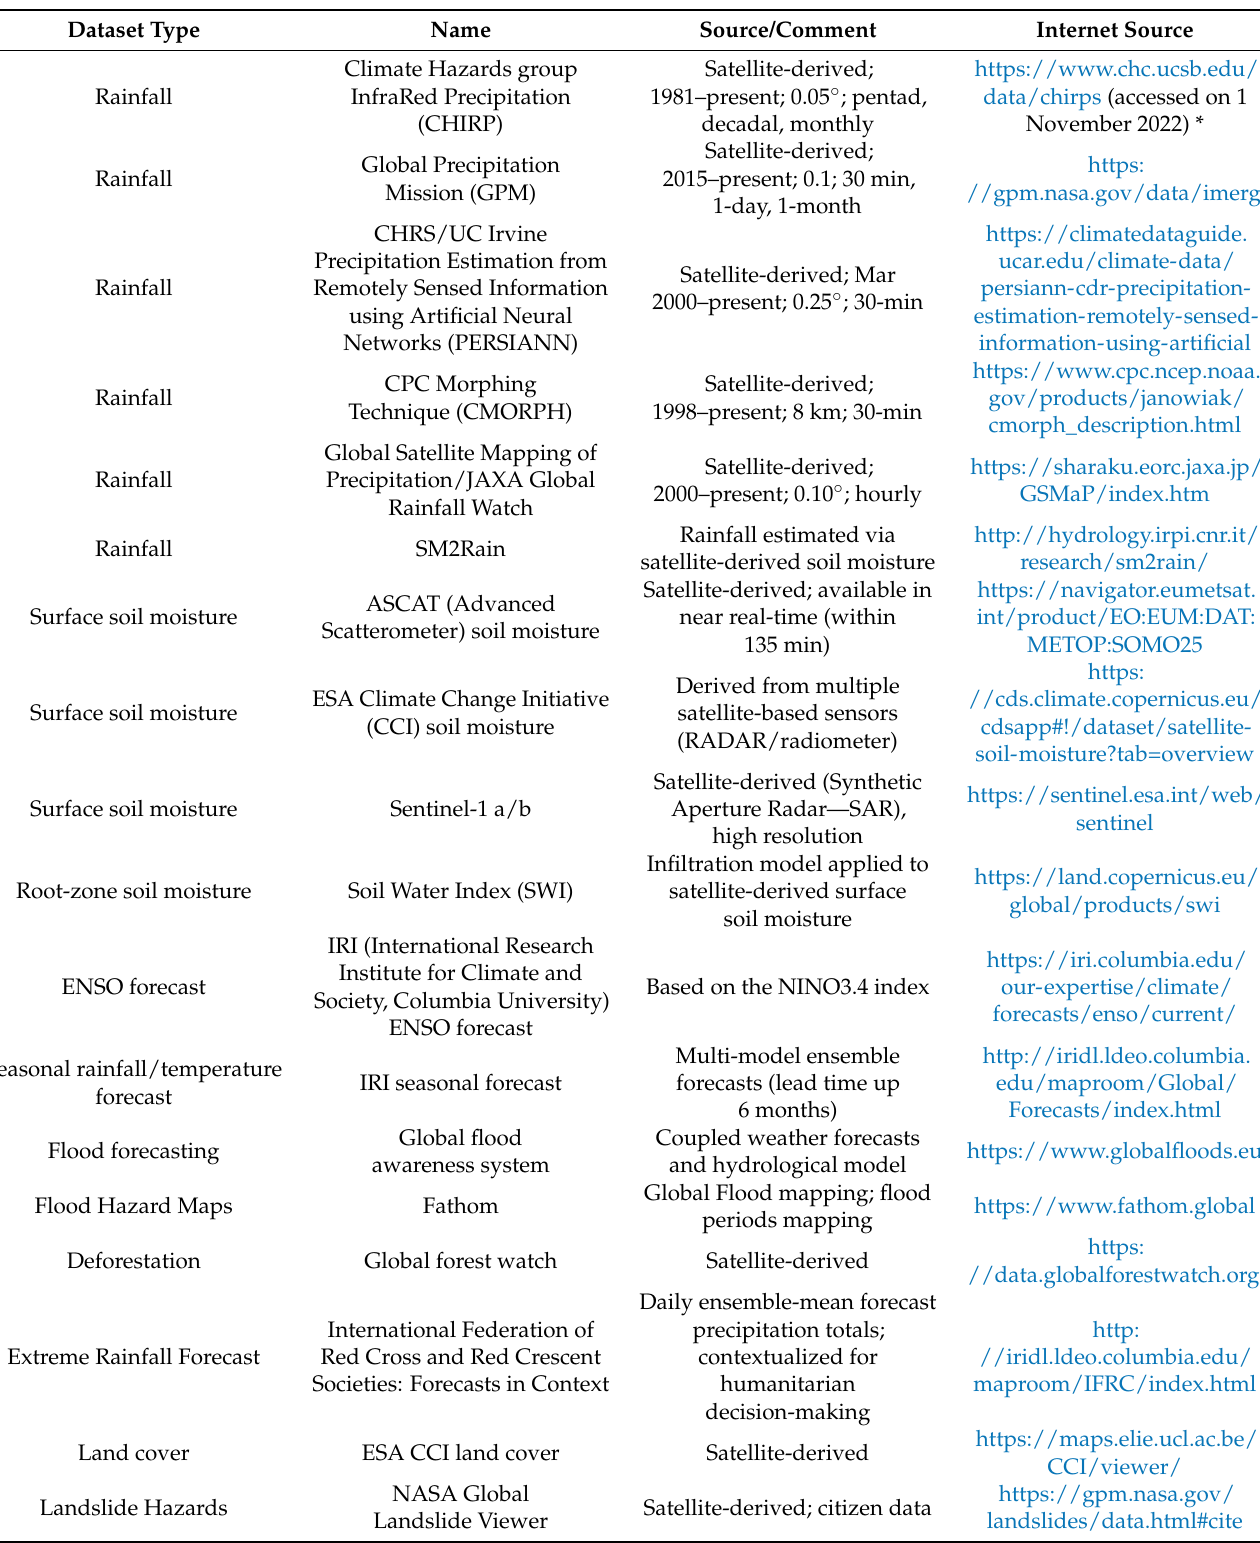
Table 1. EO-based data tools for the potential study of flood and landslide susceptibility (past flood event locations, topography, precipitation, temperature, hydrology, land cover and soil cover data), population’s exposure (demography data) and vulnerability (socio-economic data) in